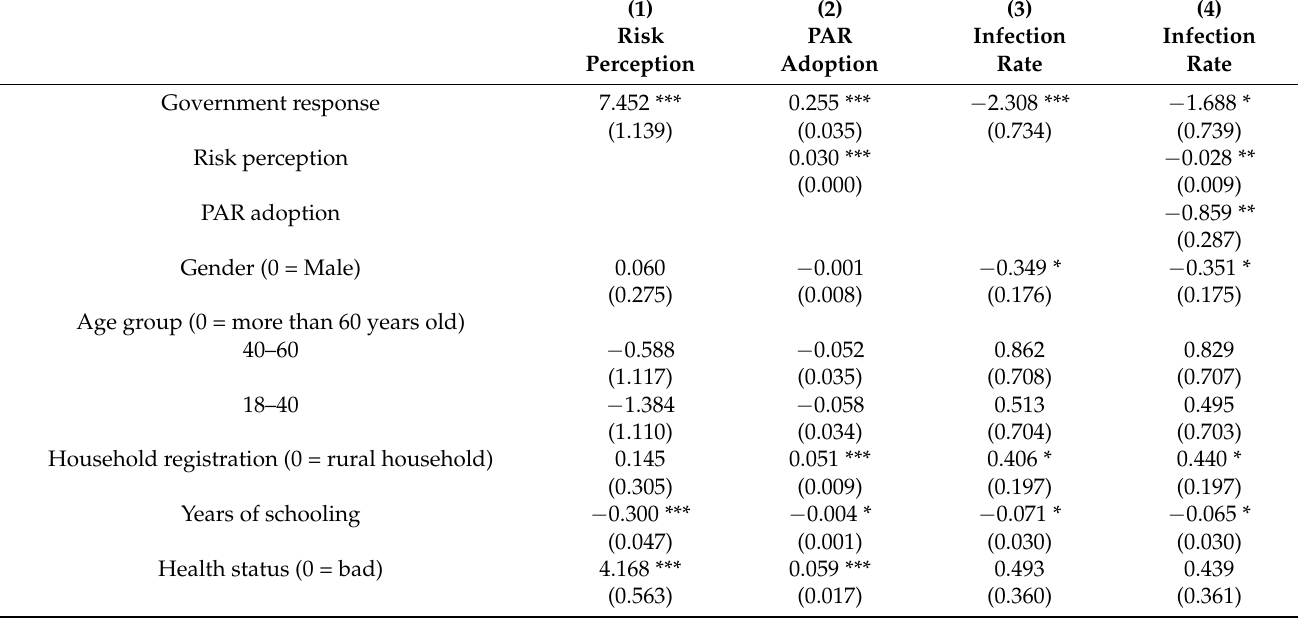
Table 4. Effects of government response on risk perception, PAR adoption, and infection